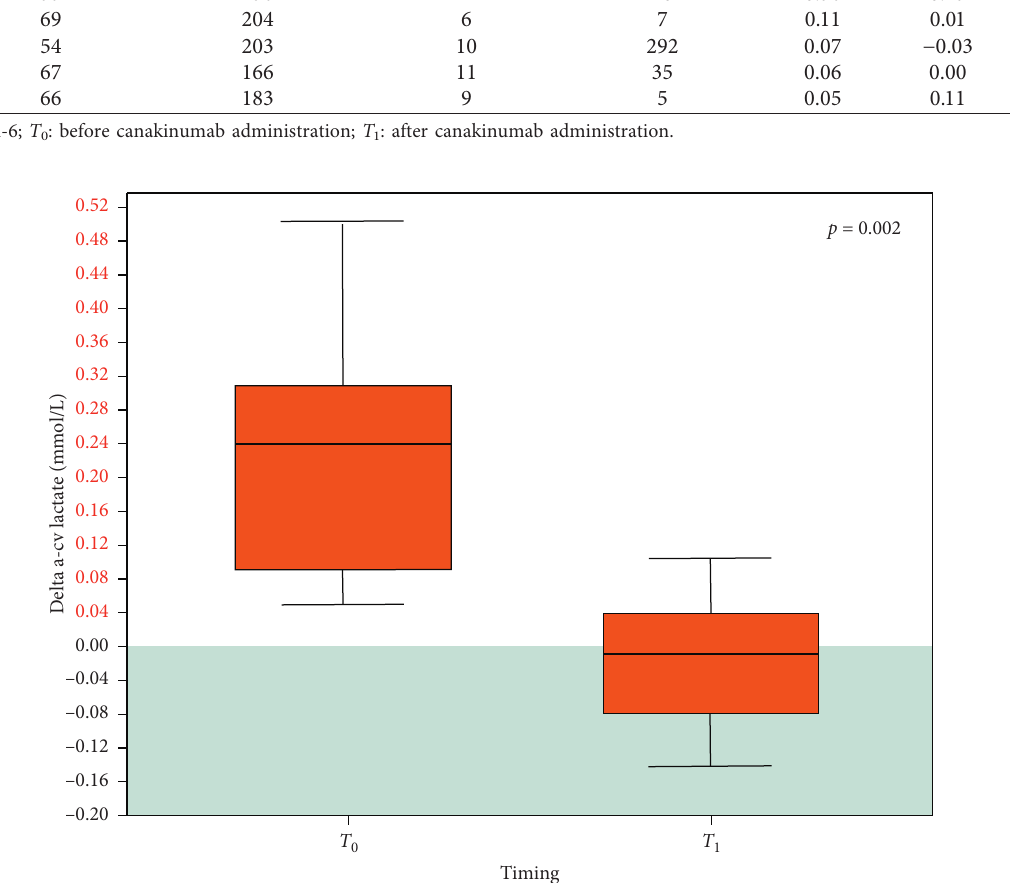
Figure 1: Delta a-cv lactate before ( T 0 ) and after ( T 1 ) canakinumab administration in 13 patients. Black horizontal line inside the boxes: median. Box height: interquartile range. Grey area: normal Delta a-cv lactate values ( ≤